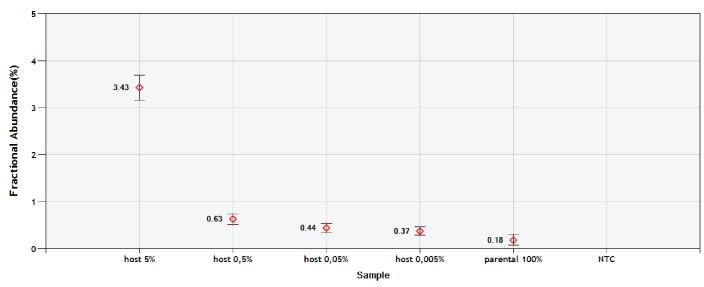
Validation of the sc/ddPCR assay for the tRNA locus.Parental mtDNA (about 20,000 copies) was spiked with 1000; 100; 10 and 1 copy of host mtDNA. Respectively, this corresponds to the expected fractions of 5; 0.5; 0.05% and 0.005%. Red diamonds indicate the measured fractions. NTC is non-template control.